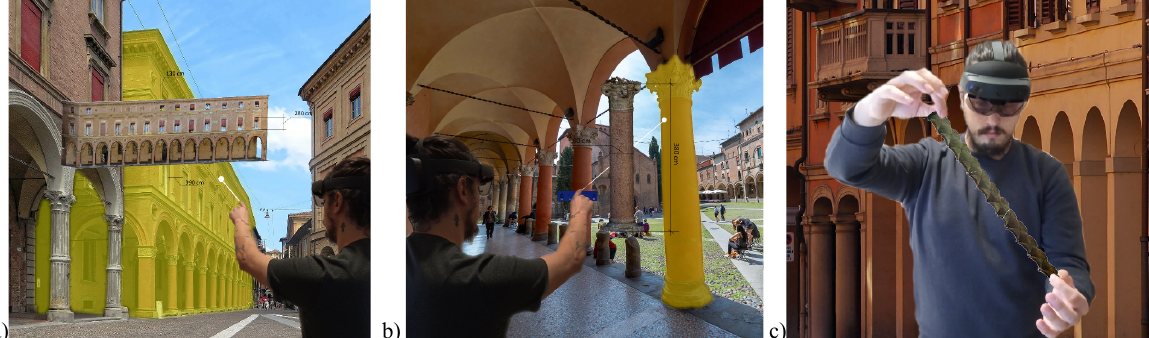
Figure 6. MR access to an entire building block (a), selection and visualisation of a segmented object in the first classification level (b) and virtual interaction with the segment “vault” class